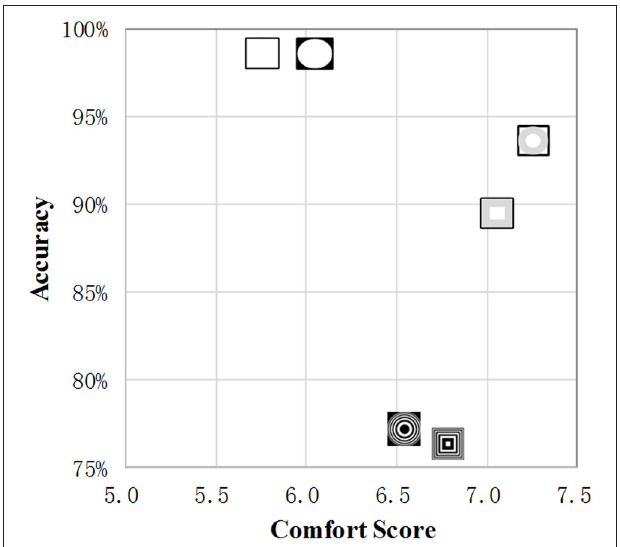
FIGURE 8 | The comfort score and recognition accuracy.